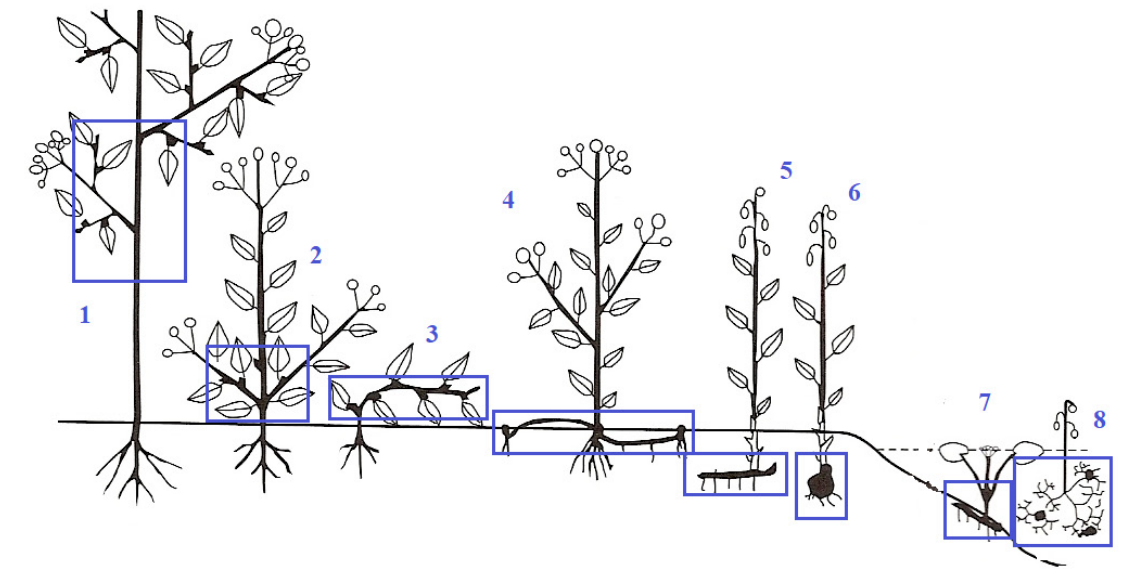
Fig 1. Vegetal life forms in accordance to Raunkiaer (1934). From to left to right: (1) Phanerophytes, the surviving buds or shoot-apices are borne on negatively geotropic shoots that project into the air; (2,3) Chamaephytes, the surviving buds or shoot- apices are borne on shoots very close to the ground; (4) Hemicryptophyte, the surviving buds or shoots-apices are situated in the soil-surface; (5,6) Cryptpphytes, the surviving buds or shoot-apices are buried in the ground at a distance from the surface that varies in the different species; Hydrophyte, the surviving buds or shoots-apices are rest submerged under water